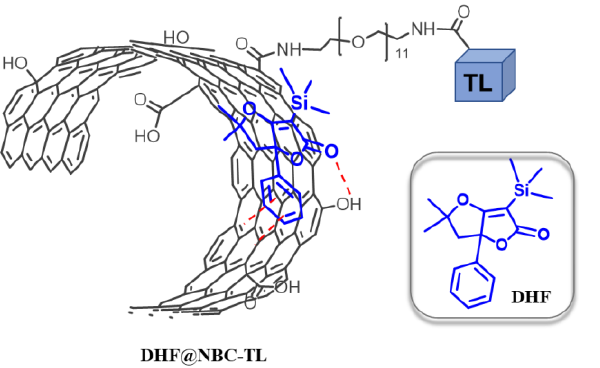
Figure 9. DHF@NBC-TL: diagram illustrating the interaction of DHF with NBC-TL.